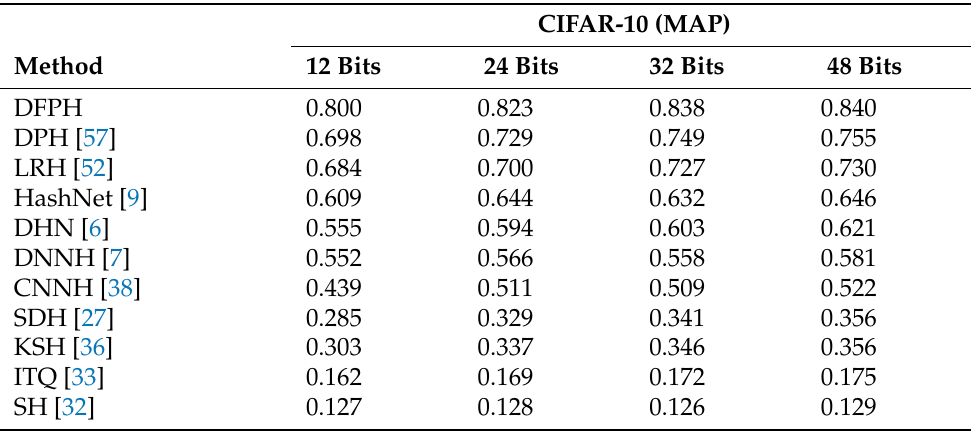
Table 2. Mean Average Precision (MAP) of Hamming ranking for different number of bits on